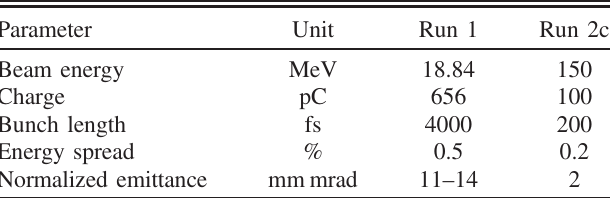
TABLE I. Beam parameters of the witness electron transfer lines for AWAKE Runs 1 and 2c [20,36].